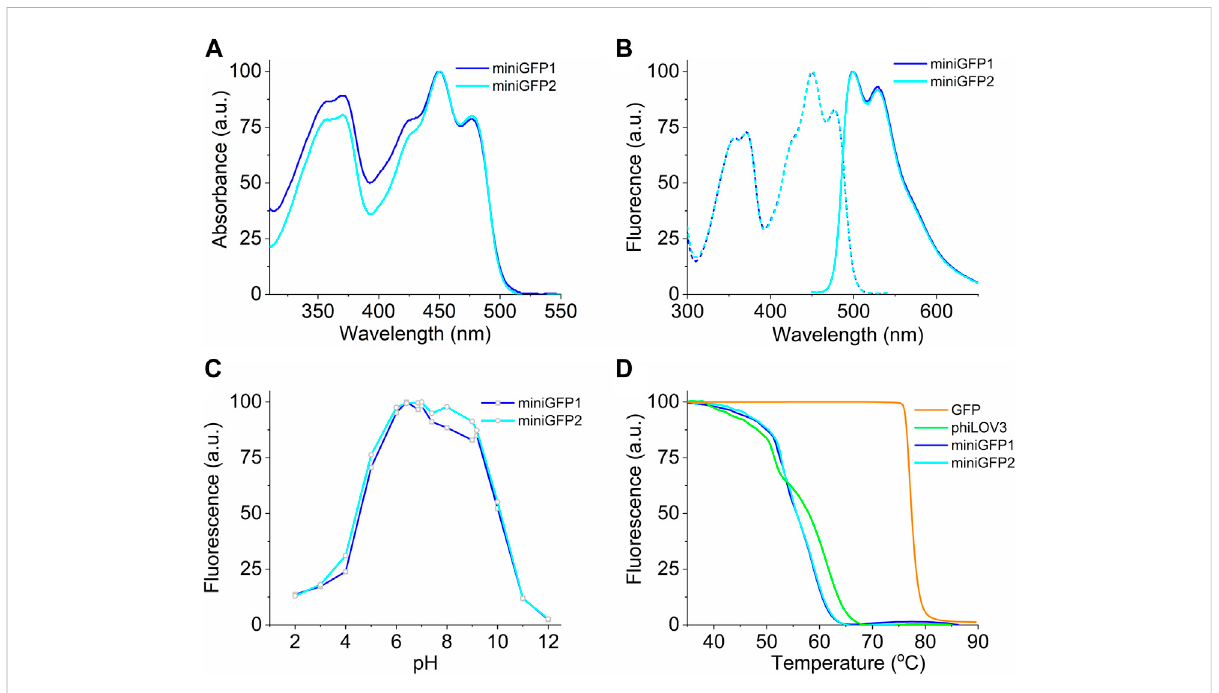
FIGURE 2 Spectral and biochemical characterization of miniGFP1 and miniGFP2 in solution. (A) Absorption spectra of miniGFP1 and miniGFP2. (B) Excitation (dashed) and emission (solid) fl uorescence spectra of miniGFP1 and miniGFP2. (C) Normalized fl uorescence of miniGFP1 and miniGFP2 under different pH values. (D) Fluorescence thermostability curves for GFP, phiLOV3, miniGFP1, and miniGFP2.